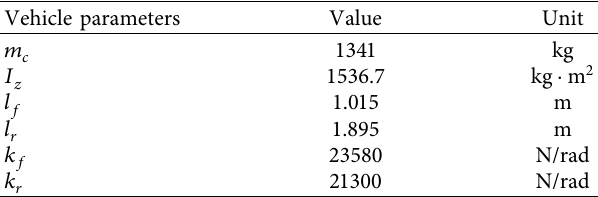
Table 1: Vehicle parameters. Vehicle